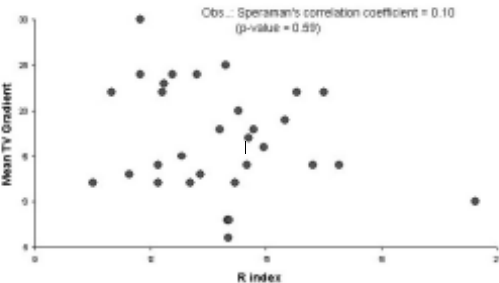
Table 1. Relationship between the mean transvalvar gradient and the R-index